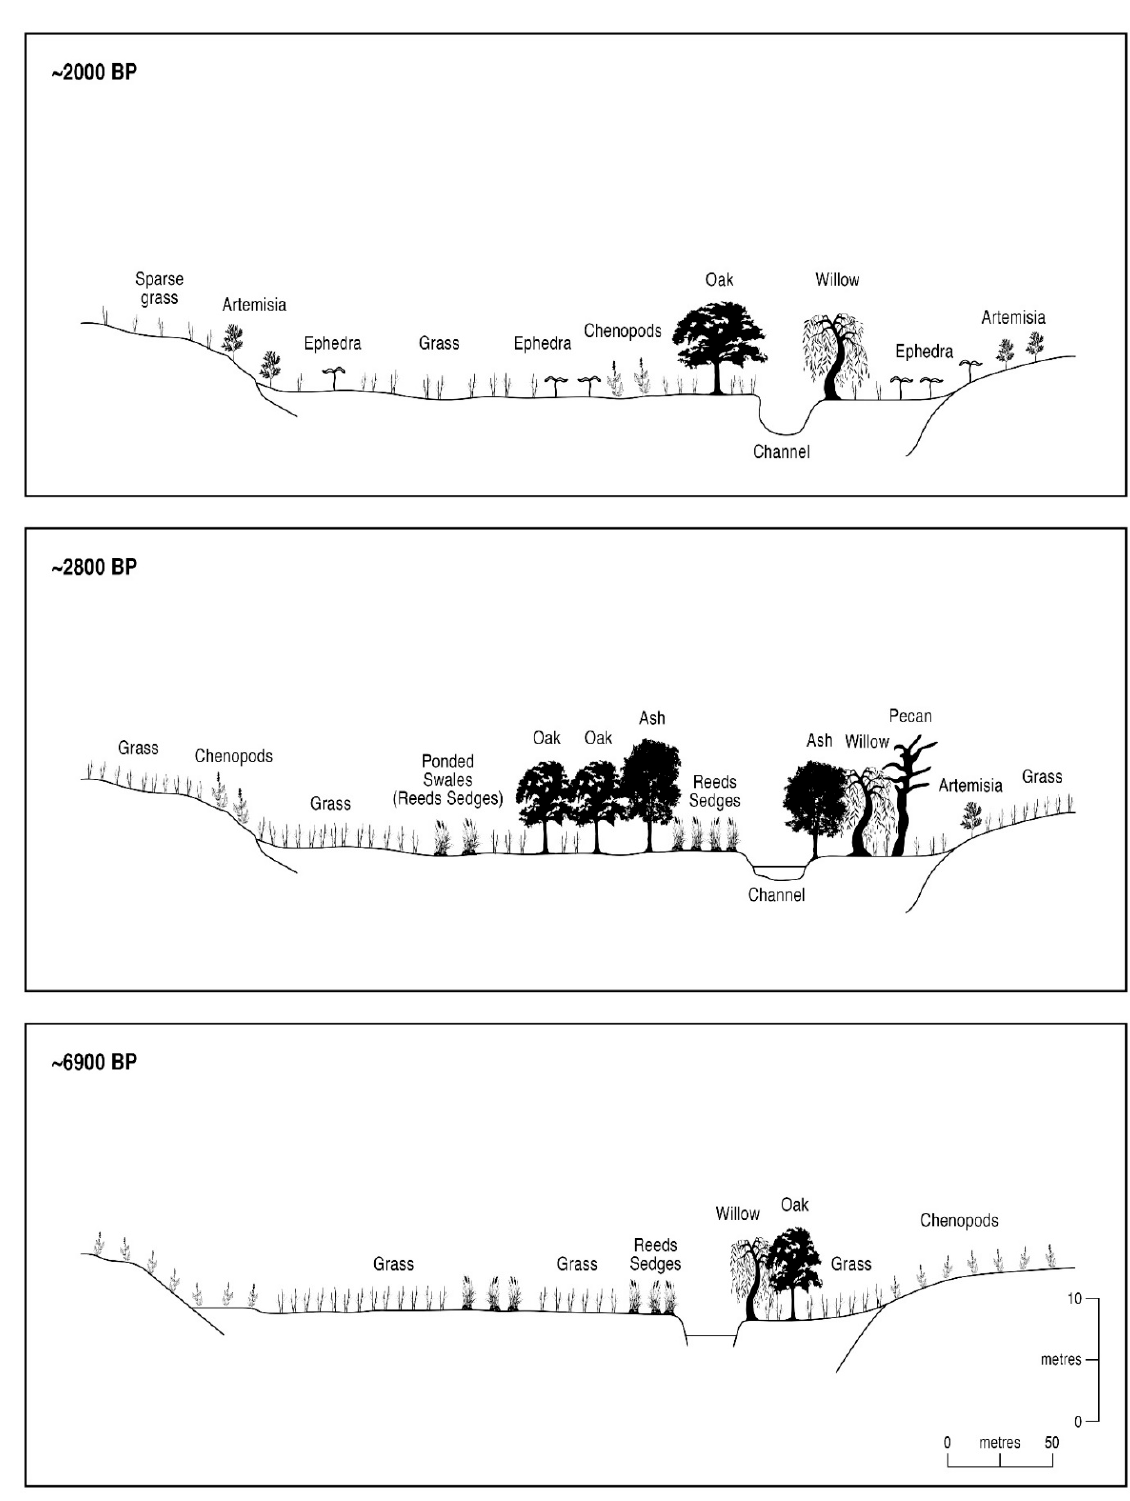
Figure 12. Reconstruction of Upper Arroyo floodplain vegetation in three Holocene intervals.